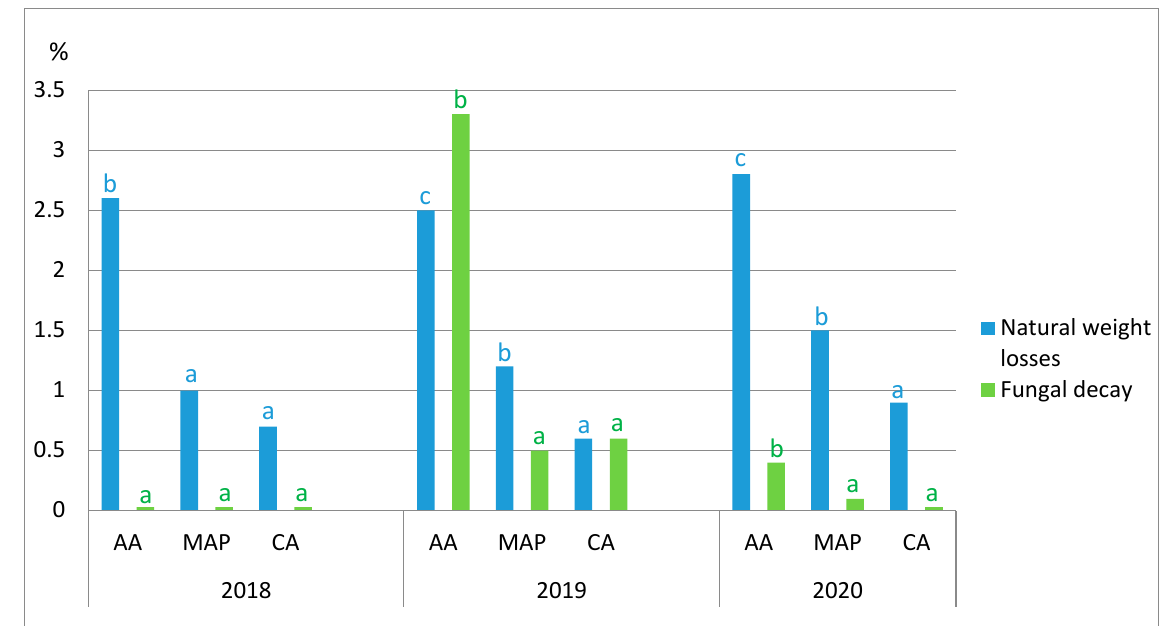
Figure 4. Natural weight losses (%) and fungal decay (%) of ‘Murano’ strawberries as affected by storage conditions. Bars characterizing fungal decay should be green (like the letters) blue letters and bars refer to weight mass